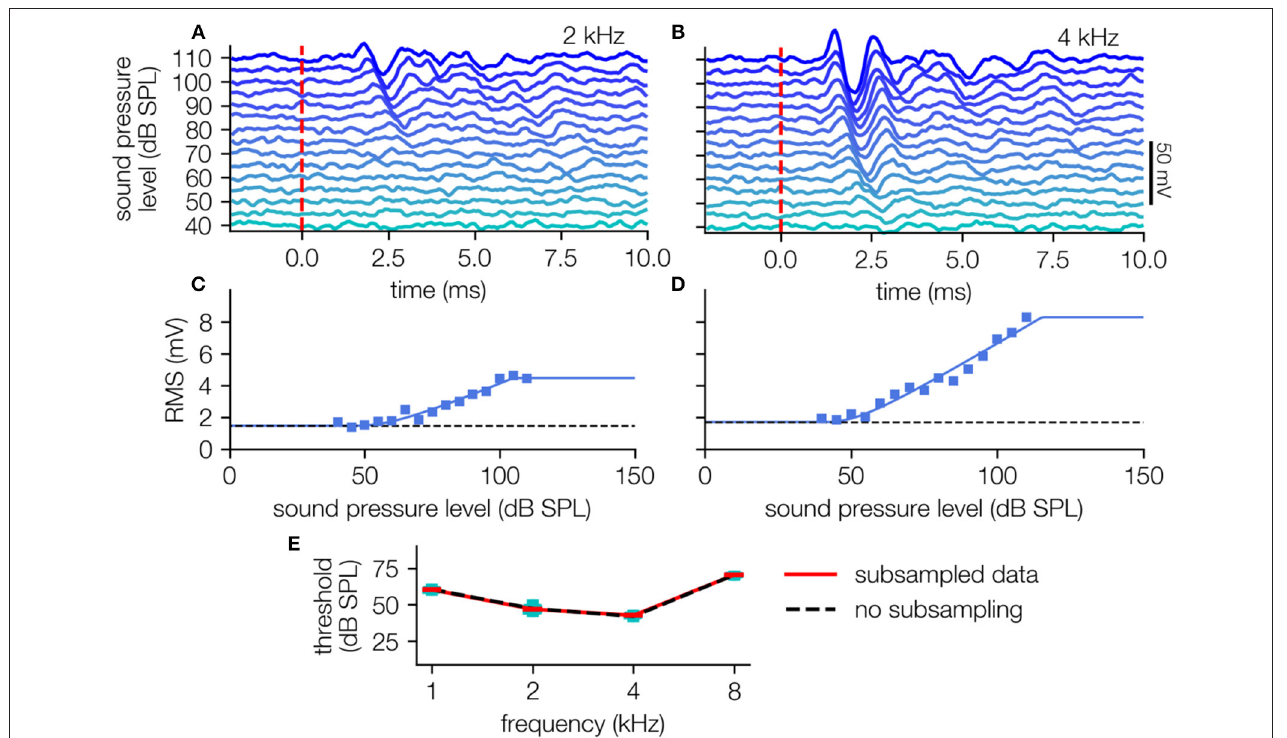
FIGURE 4 | ABR-data analysis. (A,B) ABR waves (40–110 dB SPL, cyan to blue) of one animal (2, 4kHz pure tone stimuli) averaged over 240 single trials (i.e., 120 double trials). (C,D) Level response function (blue markers) approximated using the hard sigmoid fit (blue line). (E) Audiogram with variances determined by subsampling (black dashed line: no subsampling, red line: medians, cyan boxes: quartiles, whisker 5–95% percentiles, subsampling: N